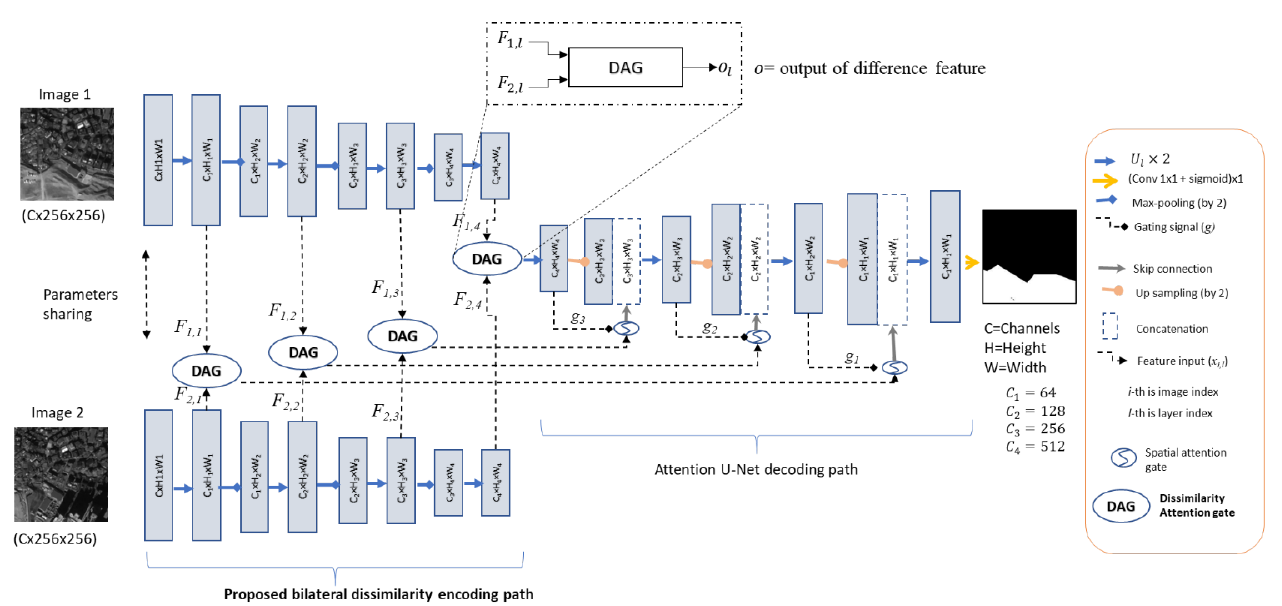
Figure 2. Proposed bilateral dissimilarity attention U-Net for change detection.